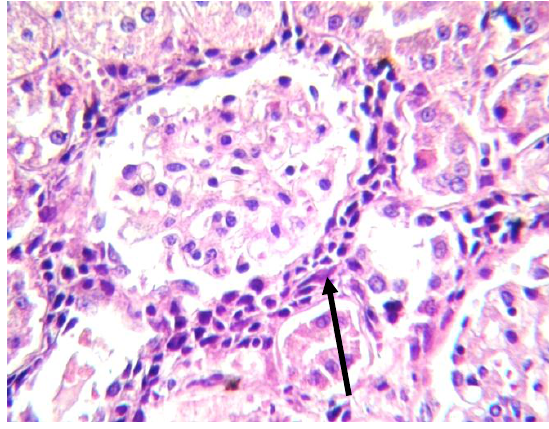
Fig 23: Microscopic section of kidney from third group during 24 – 48 hrs show cellular infiltration mainly around gluneruli (H&E X20)